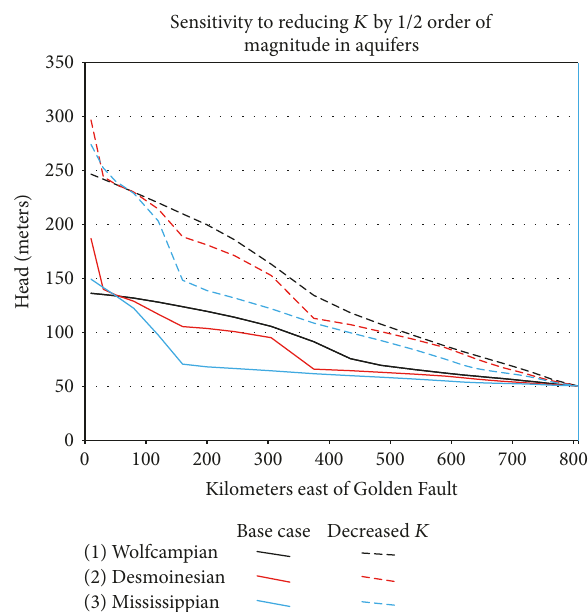
Figure 24: Sensitivity to decreasing 𝐾 by half an order of magnitude in